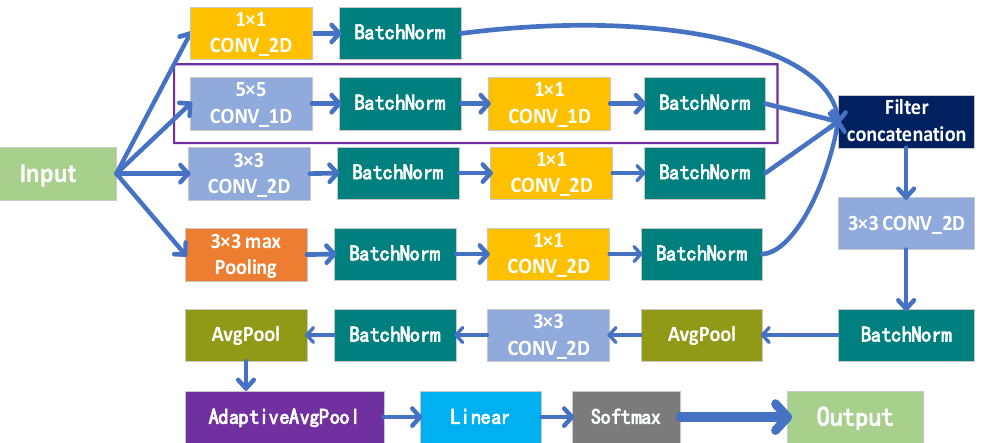
Figure 7. Schematic diagram of the overall architecture of the MDFF-CNN model.